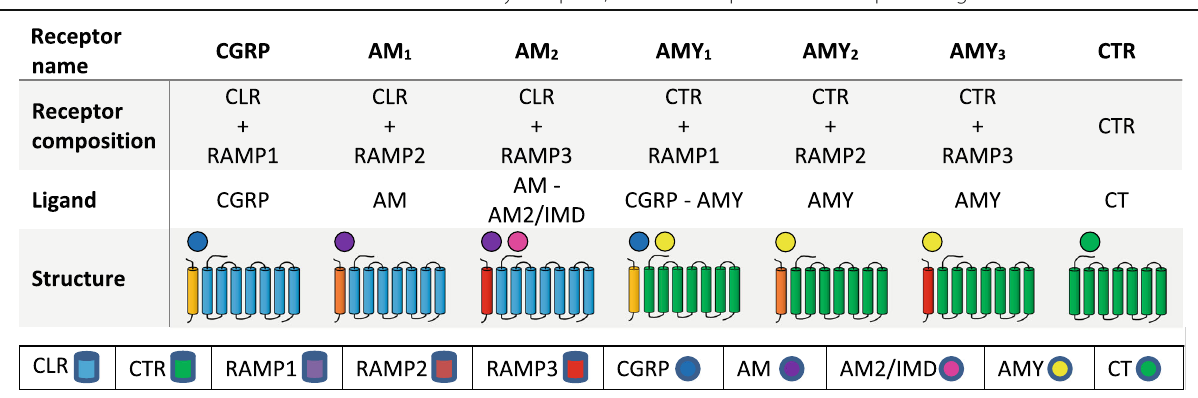
Table 1 Current classification of human calcitonin-family receptors, subunit composition and respective